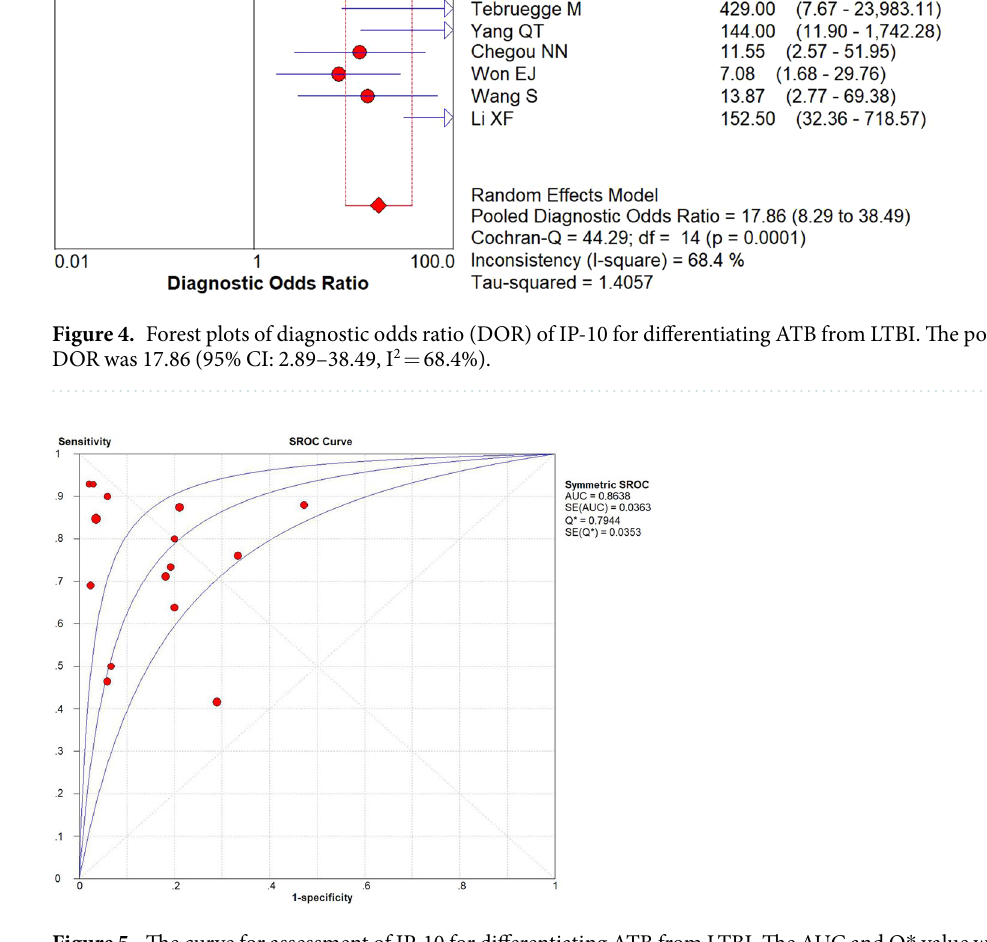
Figure 5. The curve for assessment of IP-10 for differentiating ATB from LTBI. The AUC and Q * value were 0.8638 and 0.7944, respectively. Summary receiver operating characteristic: